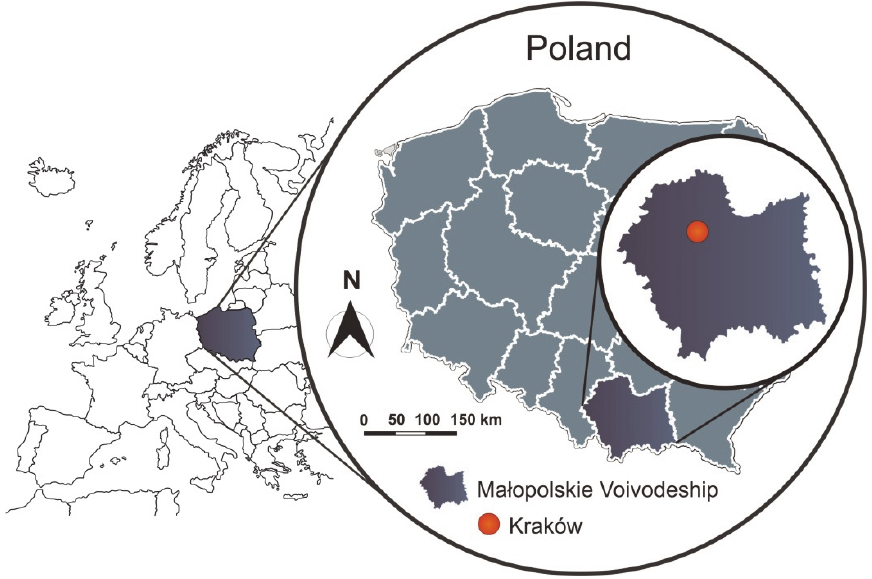
Figure 2. Ma ł opolskie Voivodeship in Europe. Source: Own work. Figure 2. Małopolskie Voivodeship in Europe. Source: Own